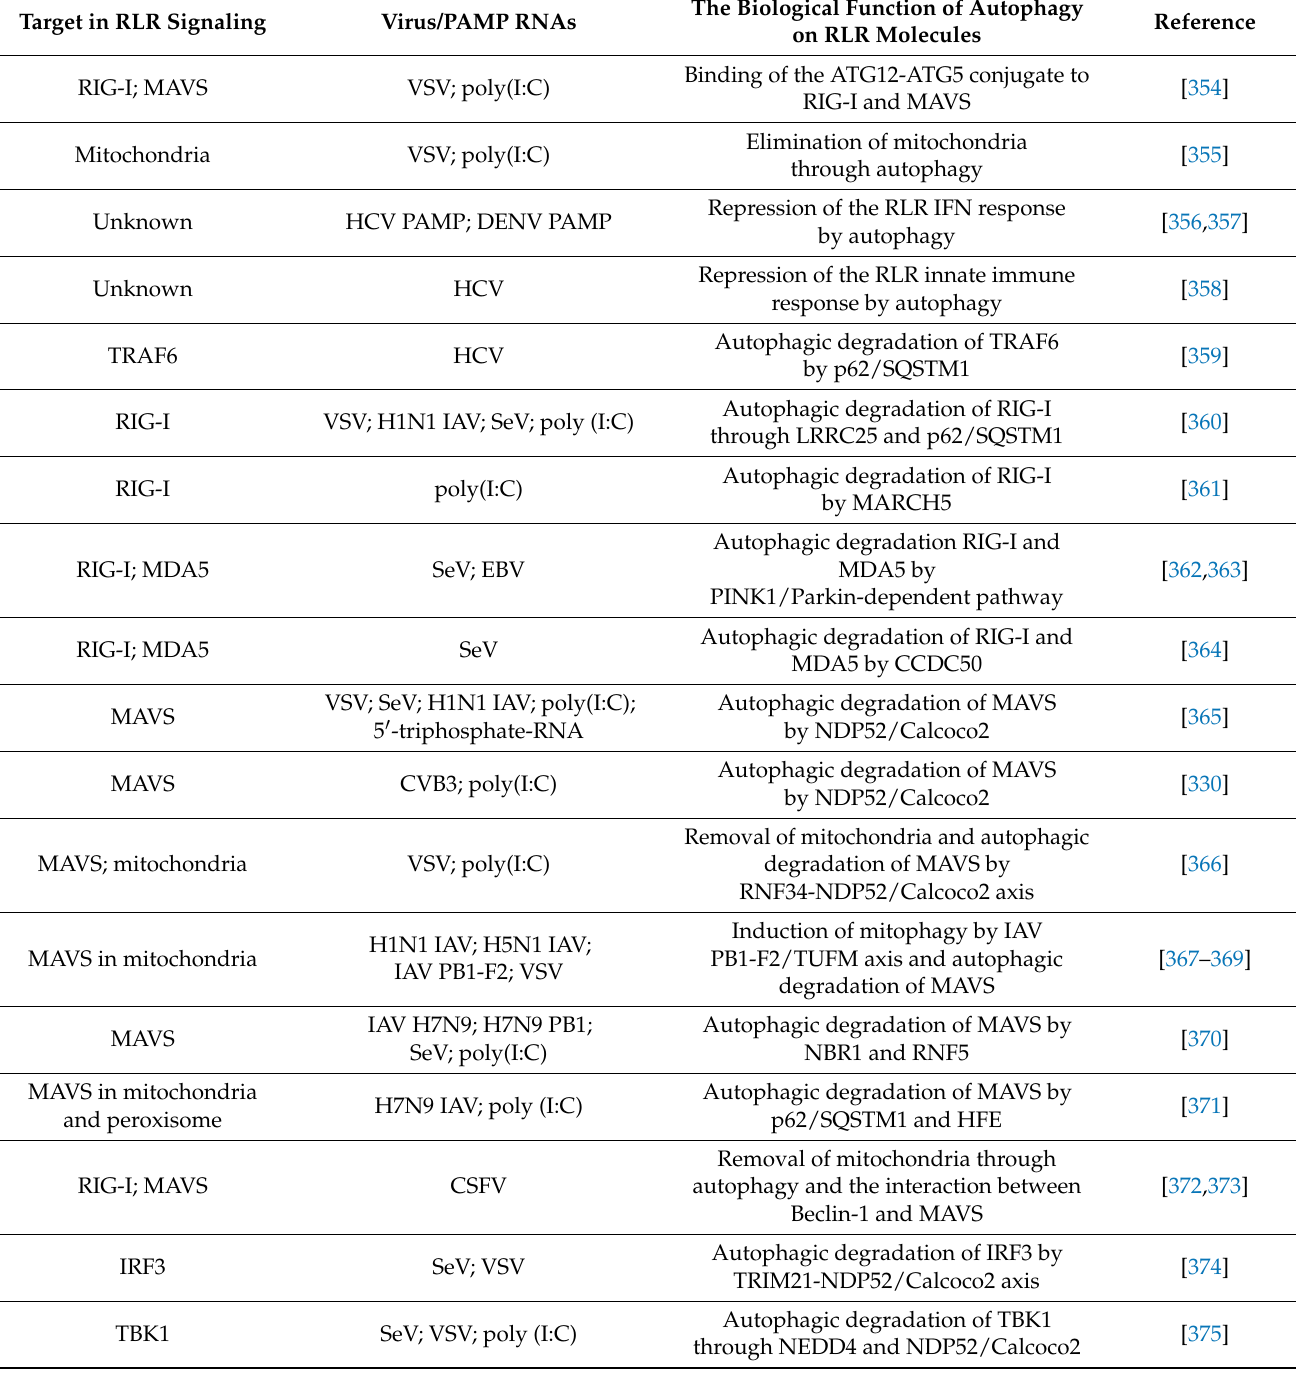
Table 1. Negative regulation of RLR antiviral signaling by